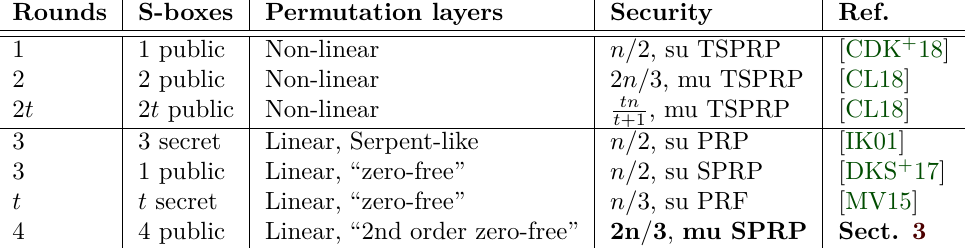
Table 1: Summary of provable result on SP-Networks. The first column presents the number of rounds in the model. The second column indicates how many S-boxes are used in the model & whether they are secret or public. Regarding security, PRF, PRP, SPRP, and TSPRP (tweakable strong pseudorandom permutation) indicate the security model, su and mu indicates if it’s in the single- or multi-user setting, while the header term indicates the concrete provable bounds. We remark that concrete security was not the focus of